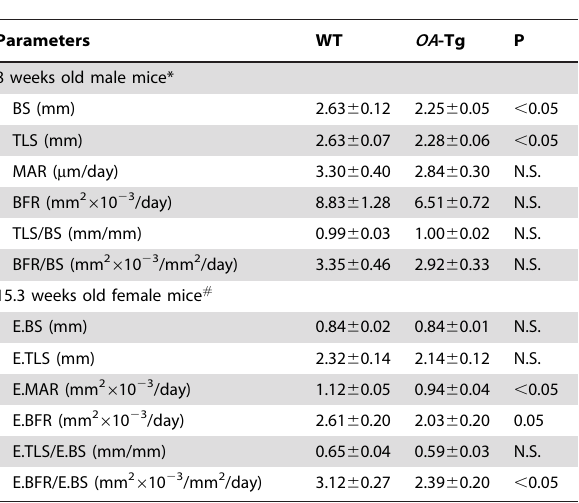
Table 4. Effects of targeted overexpression of OA overexpression in osteoclastic cells on histomorphometric bone formation parameters in 8-week-old male OA -Tg and also in 15.3-week-old female OA -Tg mice (mean 6 SEM).